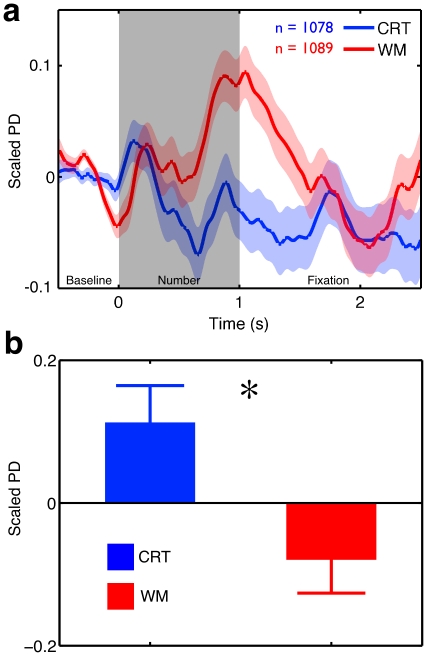
Task differences in baseline and evoked PD in the Working Memory and Choice Reaction Time tasks.(a) Thirteen participants from Experiment Two passed the quality control cut-offs and are included in this analysis. Time courses locked to non-probe stimulus presentation were created for each trial for each individual and each task. Values were averaged into ten 250 ms bins and compared using a 2×10 ANOVA with factors of Task [2 levels] and Epoch [10 levels]. A significant Task×Time interaction (F (9, 99) = 3.96, p<.001, η2 = .25) indicated differences in the pupil response to non-colored stimuli across the tasks. No other main effects or interactions were statistically significant (all p-values>.05). Contrast analysis examining the difference between conditions indicated the larger evoked response in the WM task accounted for 71% of the variance (F (1, 11) = 28.1, p<.001, η2 = .71). (b) To examine tonic pupil size we compared the mean non-baselined PD in the 1.5 seconds prior to the presentation of non-colored stimuli for the participants in Experiment Two. An ANOVA including the task order as a comparison revealed that PD was substantially higher in the CRT task than in the WM task (F (1, 11) = 5.48, p<.05, η2 = .38). Neither the main effect of task order nor the interaction between task order and task was significant (all p-values>.05).